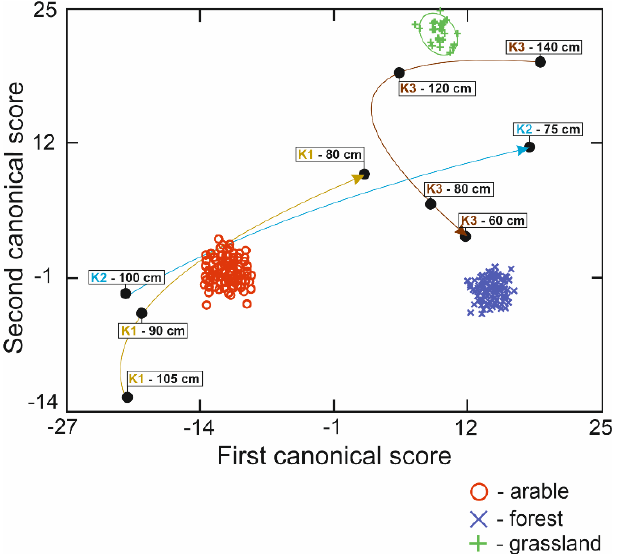
Figure 5. Canonical scores of arable, grassland, forest soils and buried humus horizons from three Neolithic kurgans (black circles with depth indication).